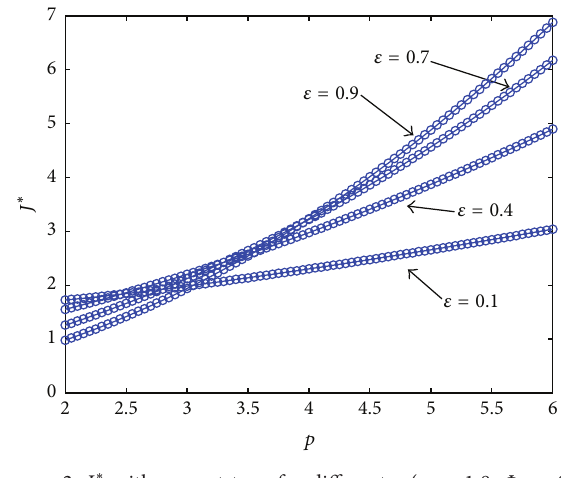
Figure 2: 𝐽 ∗ with respect to 𝑝 for different 𝜀 ( 𝑞 = 1.8 , Φ = 0.2 , Π = 0.6 , and Λ = 0.6